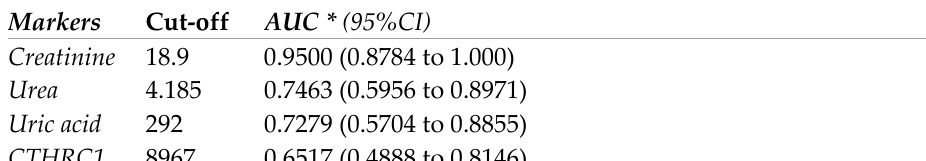
Figure 5 . ROC curve and AUC for CTHRC1 levels and other markers in patients with eGFR rates below 60 mL/min/1.73 m 2 (eGFR < 60) and above 60 mL/min/1.73 m 2 (eGFR > 60). Cut-off values